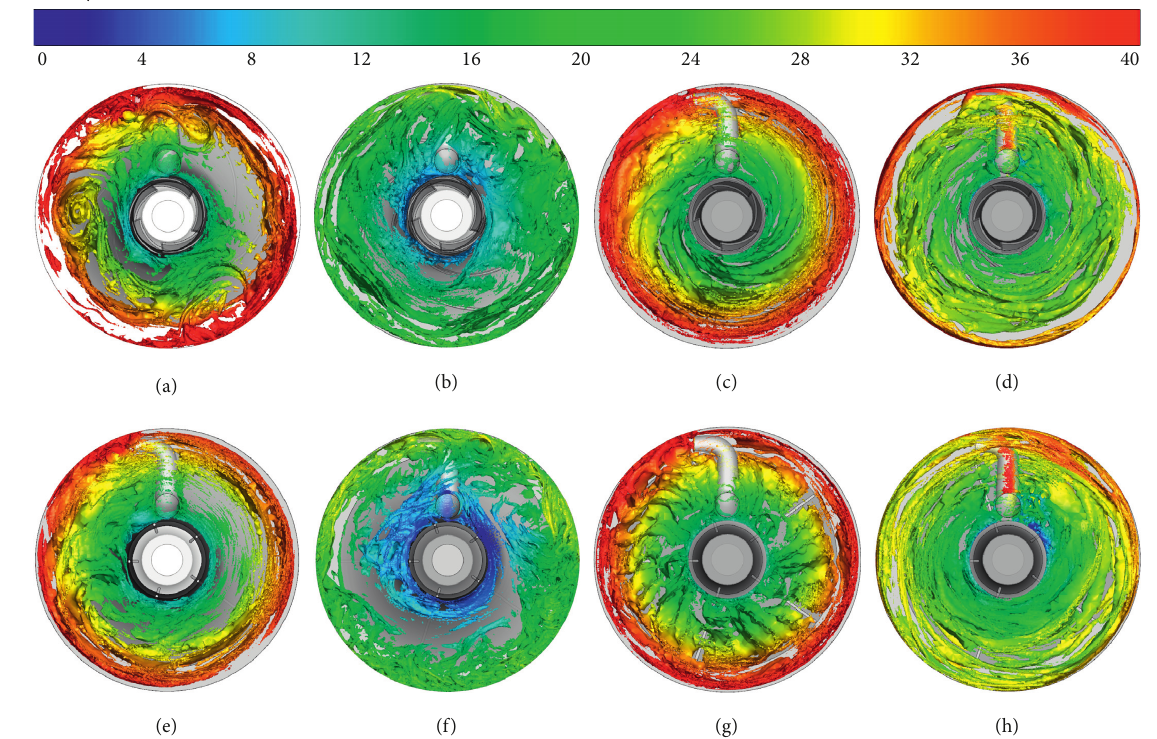
Figure 9: Regional vortex core distribution of different schemes with same Q values � 10000. (a) S (h) S 8